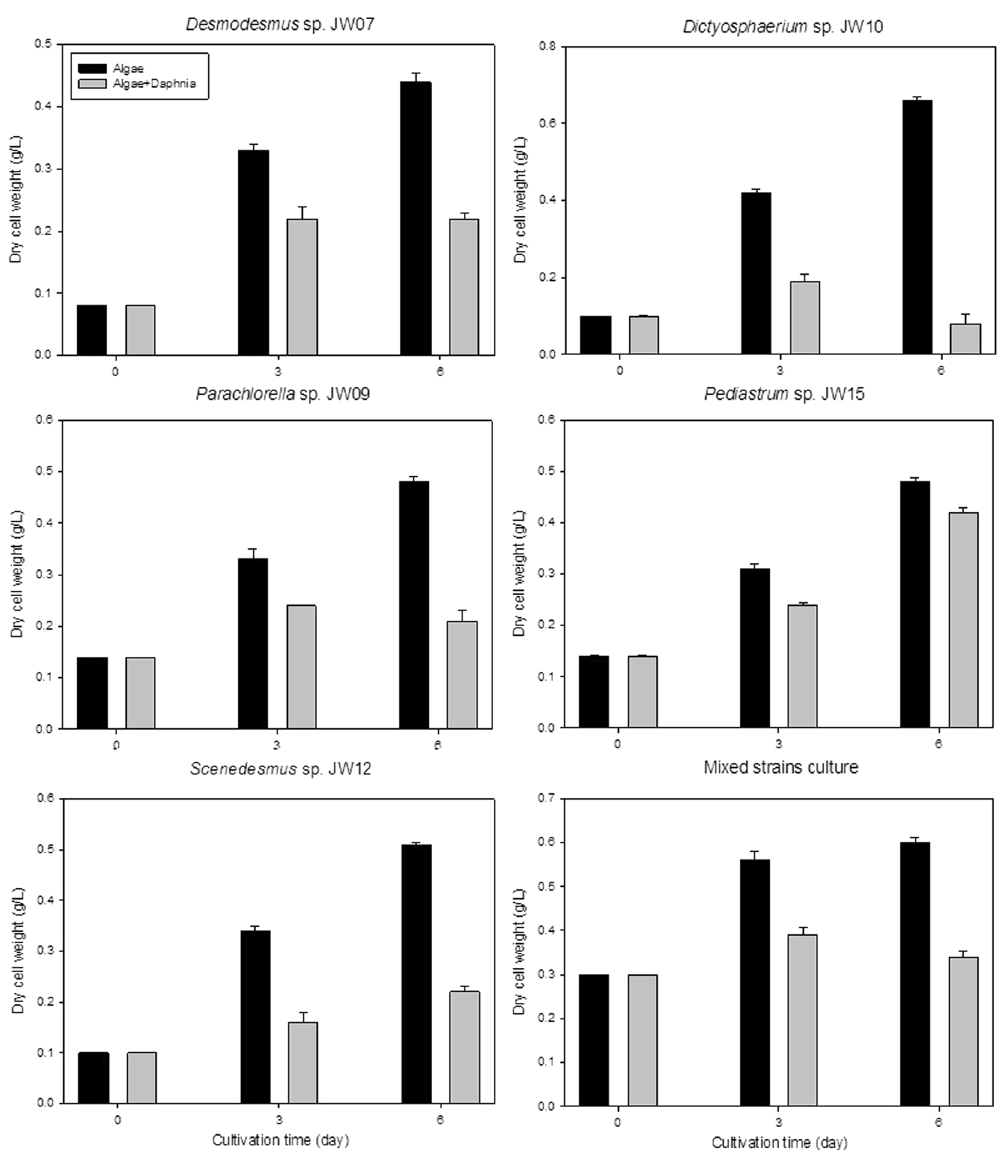
Figure 6. Co-cultivation study of isolated, indigenous microalgal strains with Daphnia isolated from the